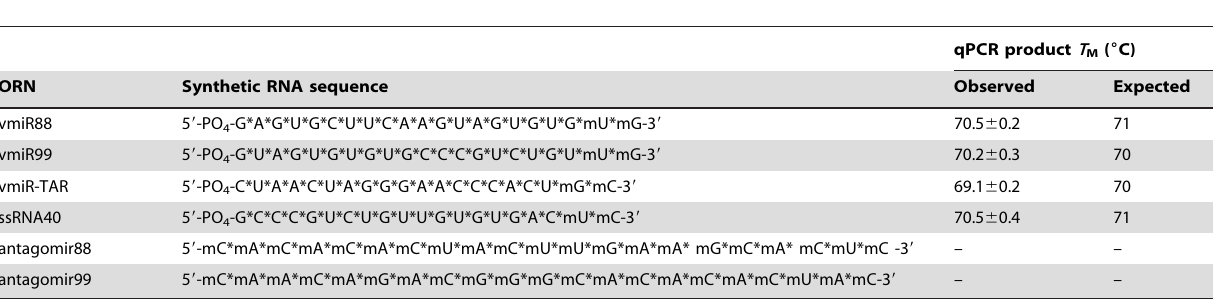
‘‘*’’: phosphorothioate linkage ‘‘m’’: 2 9 -O-methyl modification doi:10.1371/journal.pone.0106006.t001 PLOS ONE |